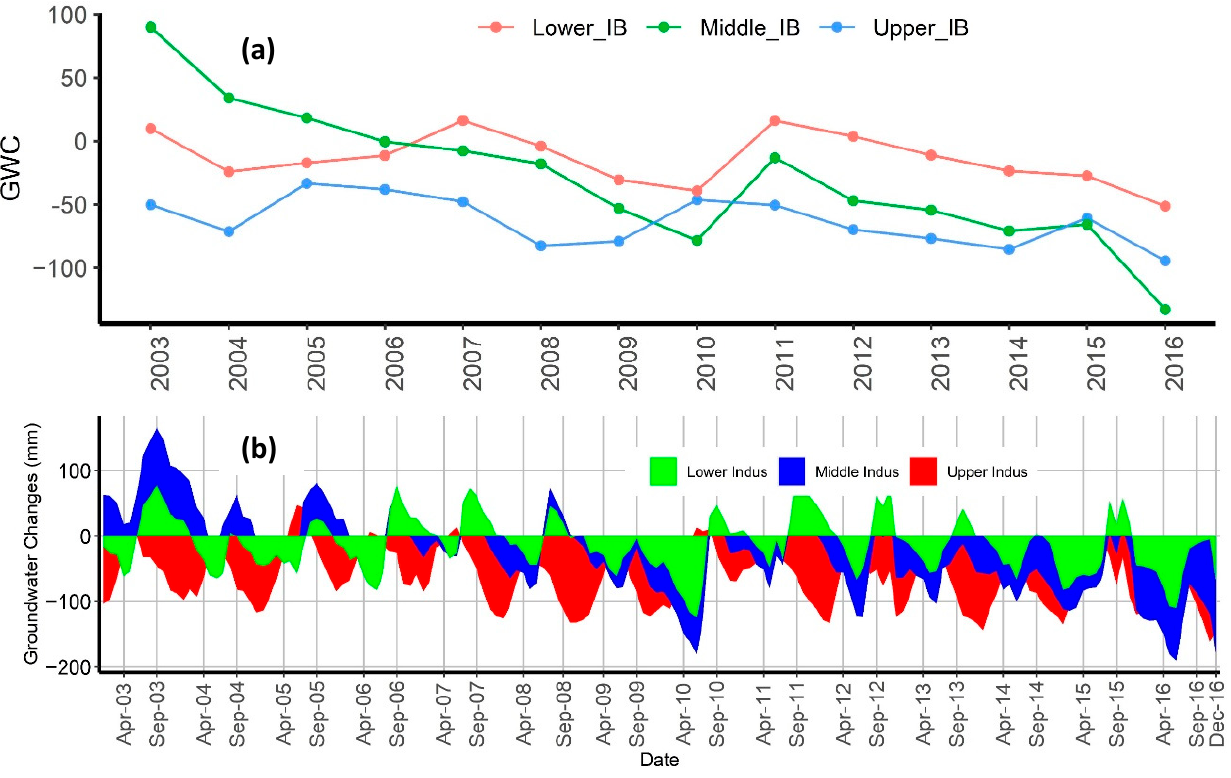
Figure 8. ( a ) Annual time series of the mean spatial groundwater storage changes in the three reaches of IRB. ( b ) Mean monthly GWC (mm/month) at different reaches in IRB.